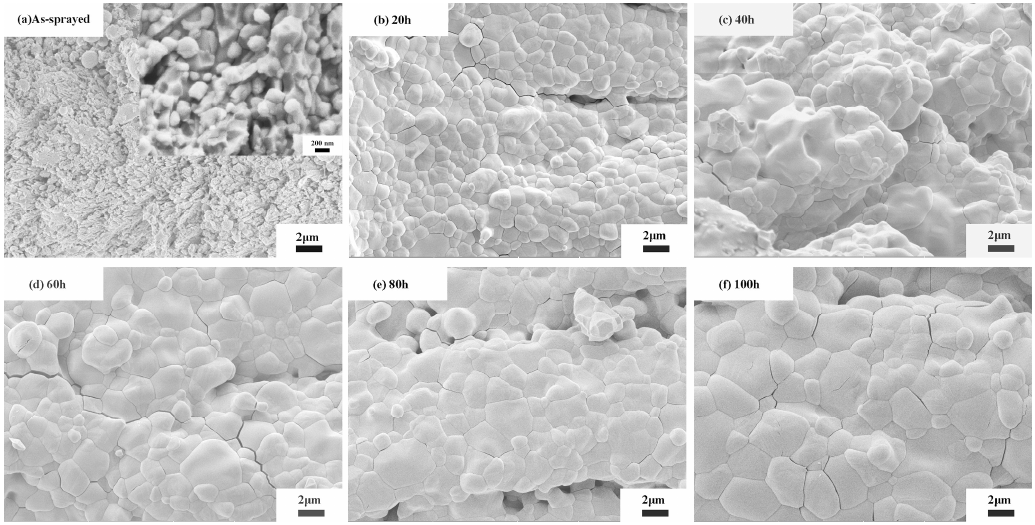
Figure 3. SEM micrographs of fracture surface of PS–PVD TBCs as a function of time: ( a ) as-sprayed; ( b ) 20 h; ( c ) 40 h; ( d ) 60 h; ( e ) 80 h; ( f ) 100 h.